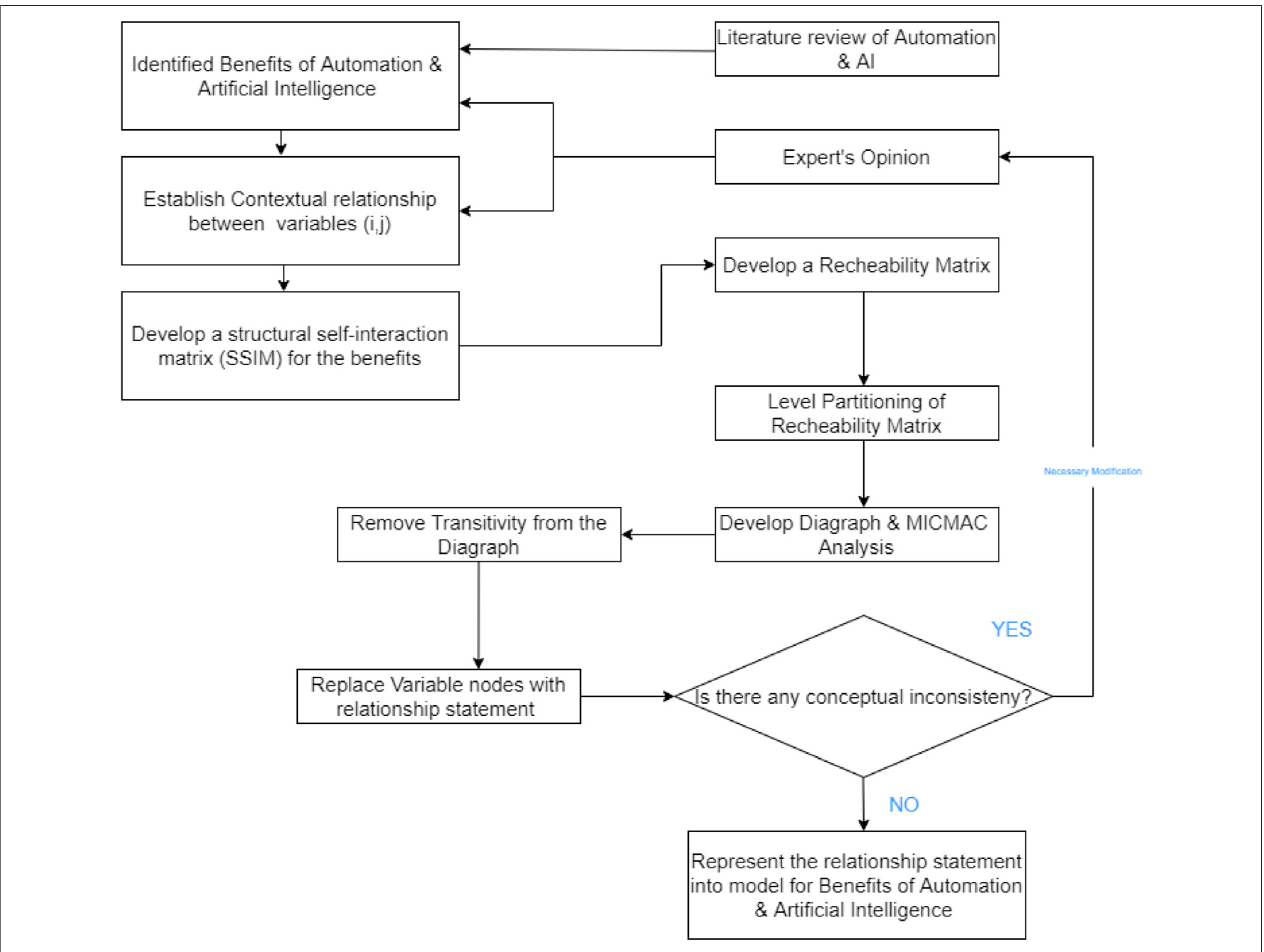
FIGURE 1 | ISM methodology as adapted from Mandal and Deshmukh (1994).